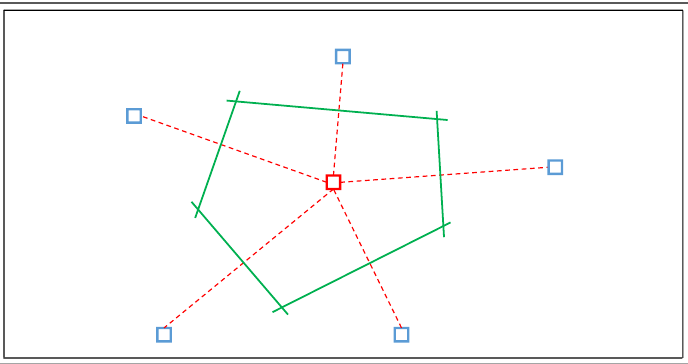
Figure 3. Example of the perpendicular bisector rule.